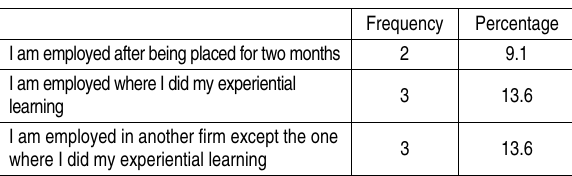
Table 2. Frequency on obtaining employment due to